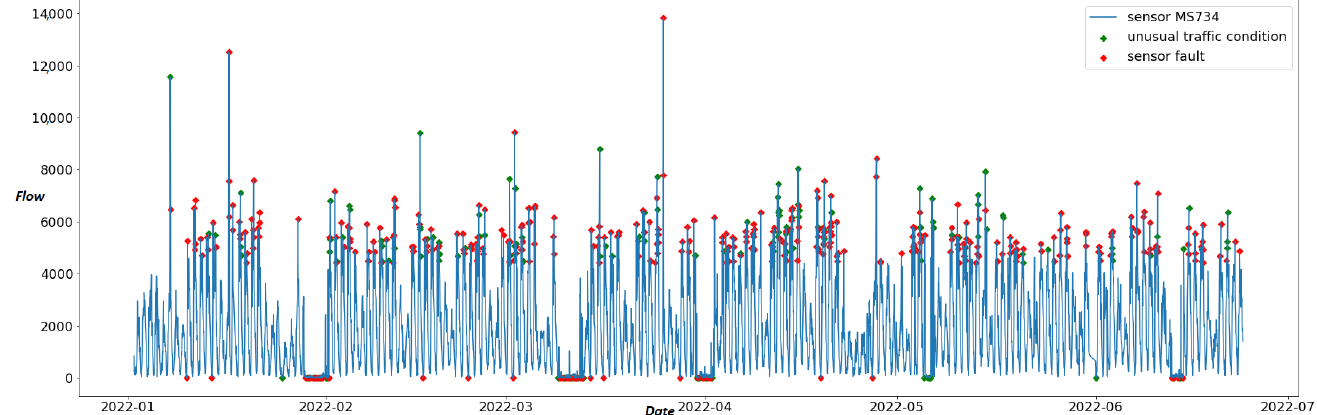
Figure 7. Time series of sensor “MS734” with anomalies detected by the iForest algorithm. Red dots are anomalies classified as “sensor faults” and green dots are anomalies classified as “unusual traffic